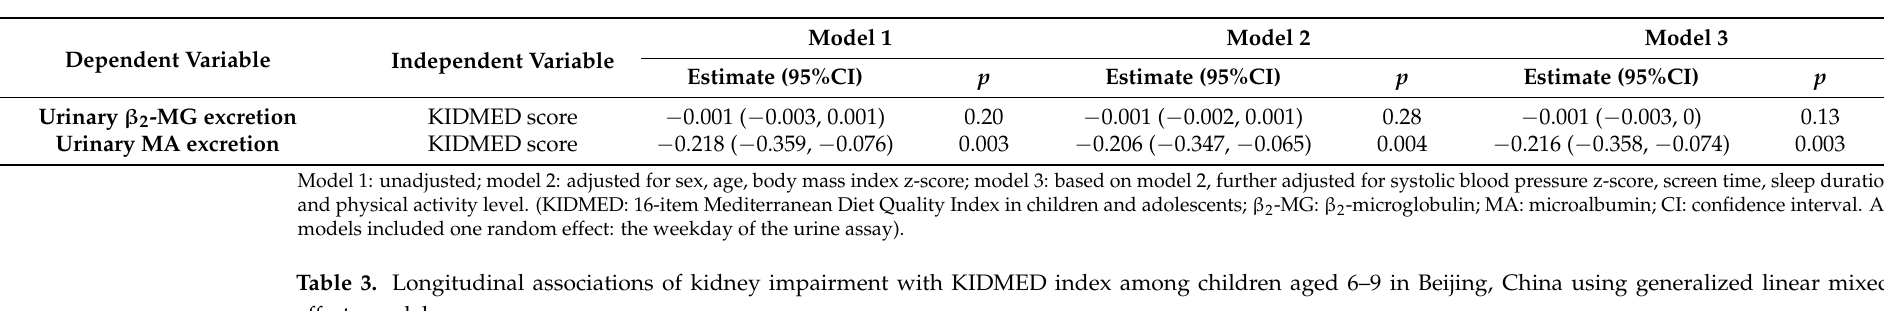
Table 2. Linear associations of indicators of kidney impairment with KIDMED scores among children aged 6–9 in Beijing, China using linear mixed-effects models.